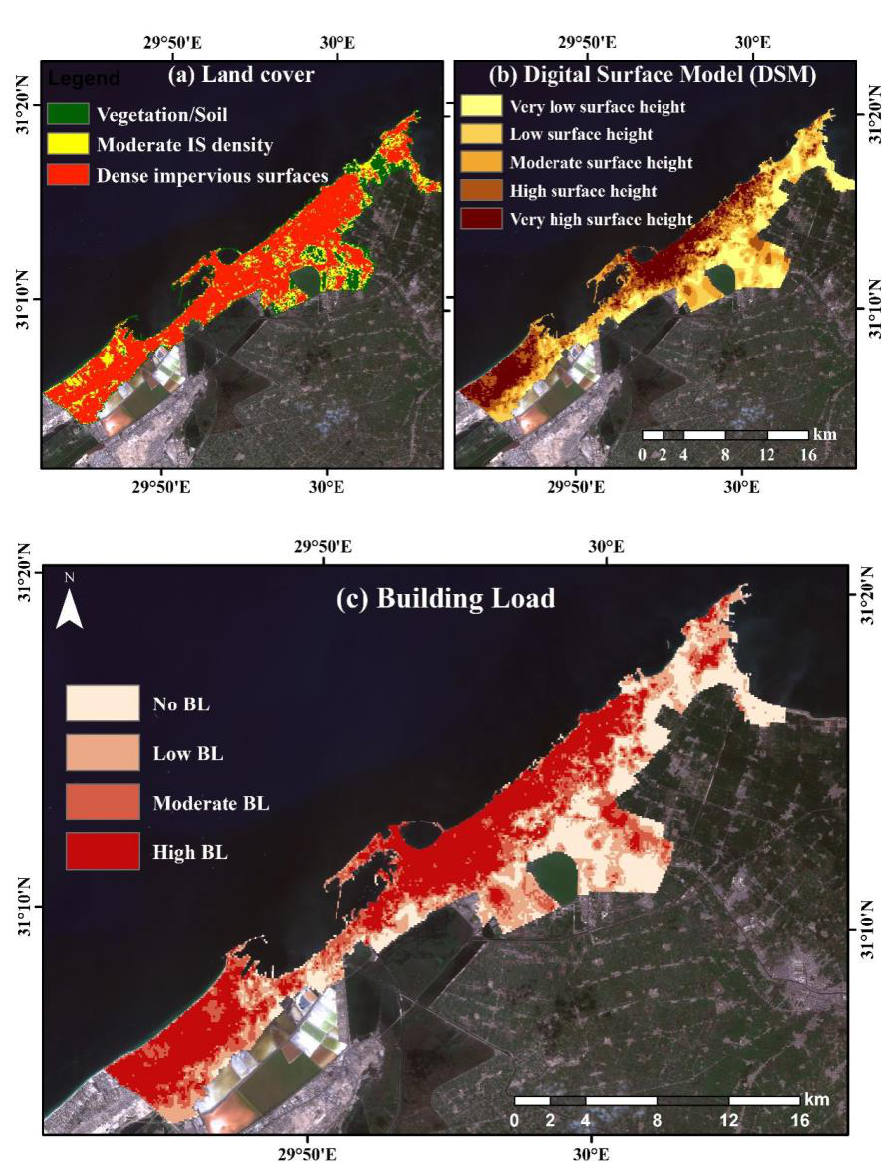
Figure 5. Building load map presented on the Sentinel-2 true color image of 24 October 2018; ( a ) aggregated land cover map, ( b ) extracted building heights, and ( c ) the final building load map.